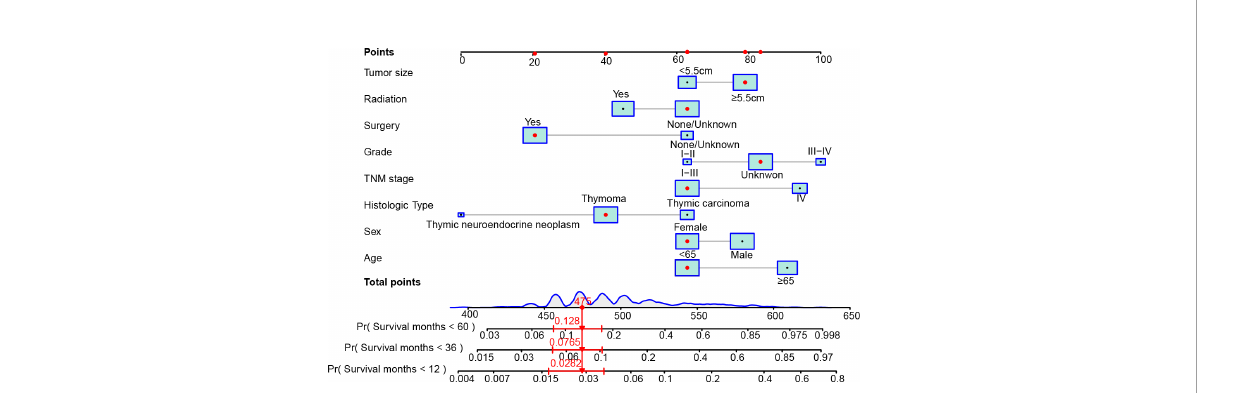
FIGURE 2 The constructed nomogram to predict the 12-, 36-, and 60-month OS of patients with TETs according to the eight independent prognostic factors identi fi ed in the multivariate Cox regression analysis. In the nomogram, the patient was a 66 years old female, diagnosed with stage IV (T 4 N 0 M 1b ) thymoma after surgery. The tumor size of this patient excessed 5.5 cm and the differentiation of the tumor was unknown. This patient did not receive radiotherapy after surgery. According to the nomogram, the total points of this patient is 475, and the probability of OS less than 12-, 36-, and 60-month of this patient is 2.82%, 7.65%, and 12.8%, respectively.